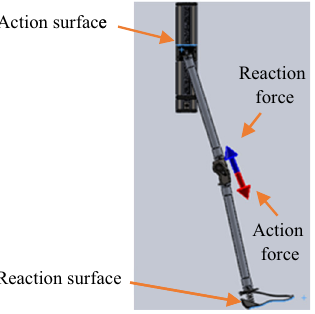
Figure 11: Action/reaction force between the upper and lower point of the prosthesis.